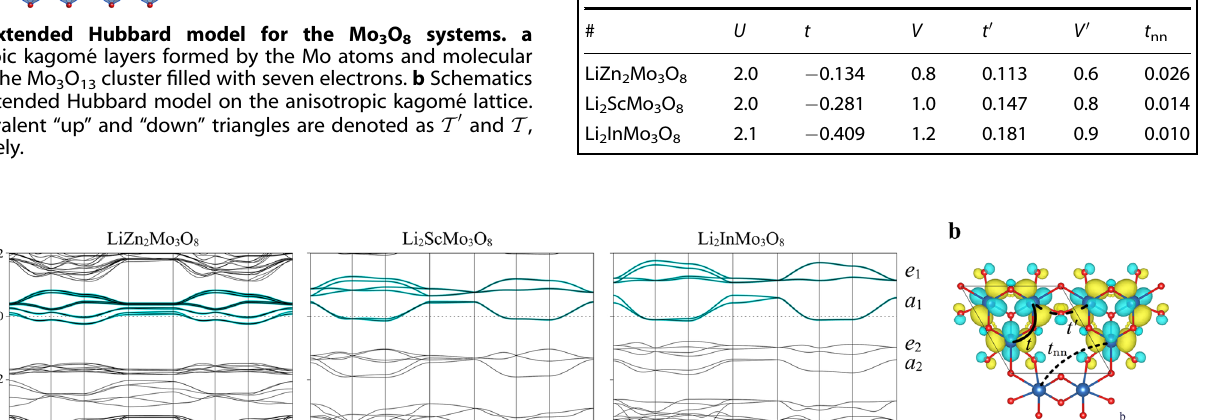
Table 1. Model parameters (in eV) for the one-orbital extended Hubbard model, Eq.